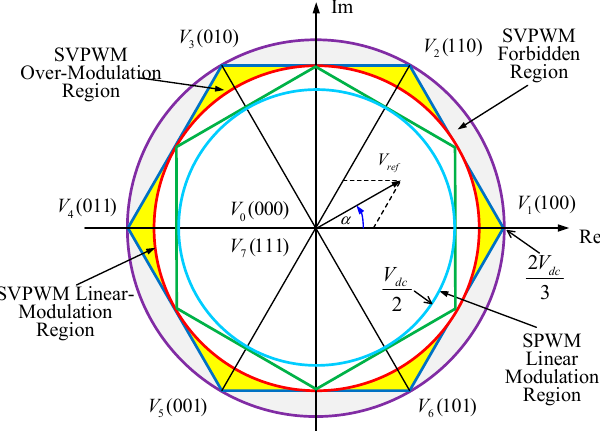
Figure 4. Linear and Over-modulation Regions in Space Vector Representation.